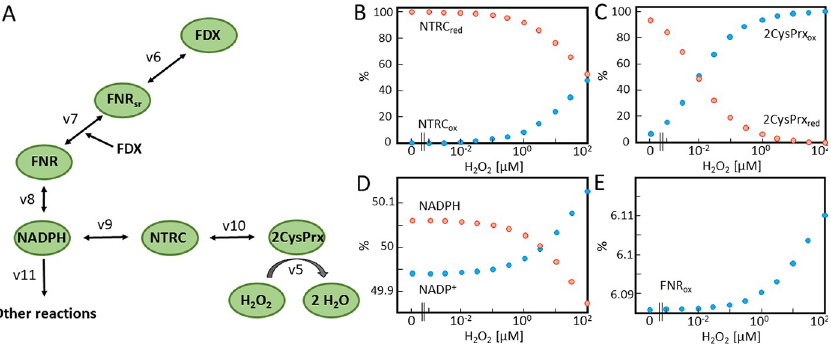
Fig 3. Simulated steady state concentration of FNR-network components at various H 2 O 2 concentrations. (A) Schematic representation of FNR-network simulated in the second model. Here, electrons passed from FDX through FNR, NADP + , NTRC to 2CysPRX and finally H 2 O 2 . Each component was able to adopt a reduced or oxidized state. FNR is represented in three states in the model; reduced (red), semi reduced (semired) and oxidized (ox). The physiological concentrations were calculated for 1 mg Chl (S2 Table). FDX was clamped to 50% reduction. Initial values of FNR red and FNR semired were set to 40%. All other oxidized forms were initially set to 20% apart from 2CysPRX at the starting point with 65% in the oxidized form [12]. The NADPH/NADP + couple was full reduced at t = 0. To mimic metabolic NADPH oxidation an additional reaction constant (v7) was added. (B-E) The redox state of the network components (B) NTRC, (C) 2CysPRX, (D) NADPH, NADP + and (E) FNR ox , was simulated for 3h at constant H 2 O 2 concentrations varying from 0 μ M to 100 μ M.